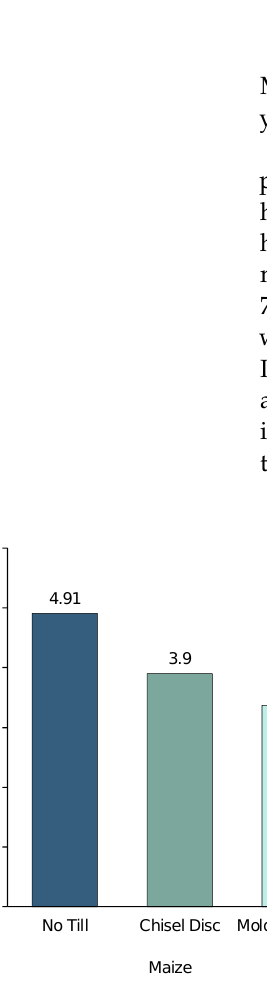
Figure 1. ERGO content of crops ( a ) maize (2018), ( b ) soybean (2019), and ( c ) oats (2020) grown using different tillage methods; different letters above the bars indicate significant difference ( p > 0.05) within each crop type, error bars represent the standard deviation of each tillage type.